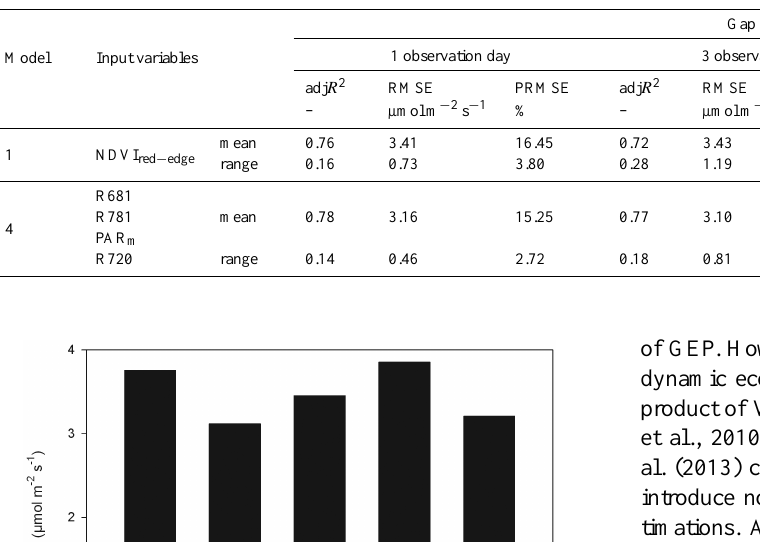
Table 6. Summary of the statistical metrics of gap-filling procedure: adjusted R 2 (adj R 2 ) , root mean square error (RMSE) and percentage root mean square error (PRMSE).